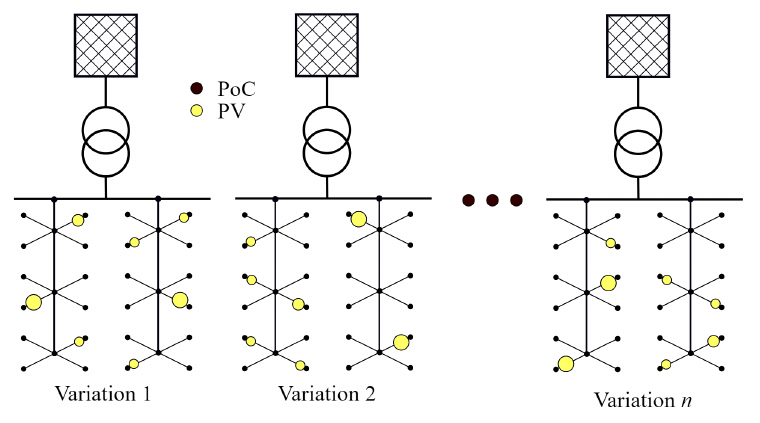
Figure 2. Multiple model VR for single DPI, e.g., the sum of power from PV